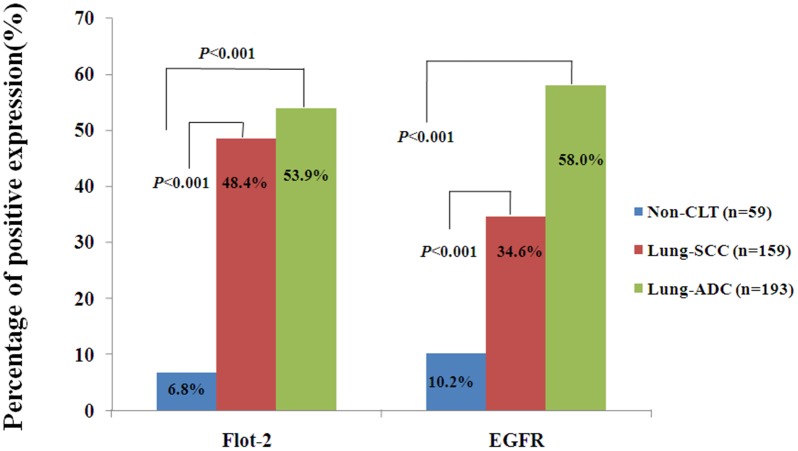
Expression of Flot-2 and EGFR proteins in lung SCC and lung ADC compared to the control of non-cancerous lung tissues.Results showed that there were significant differences between the groups which were statistically evaluated by chi-square test.